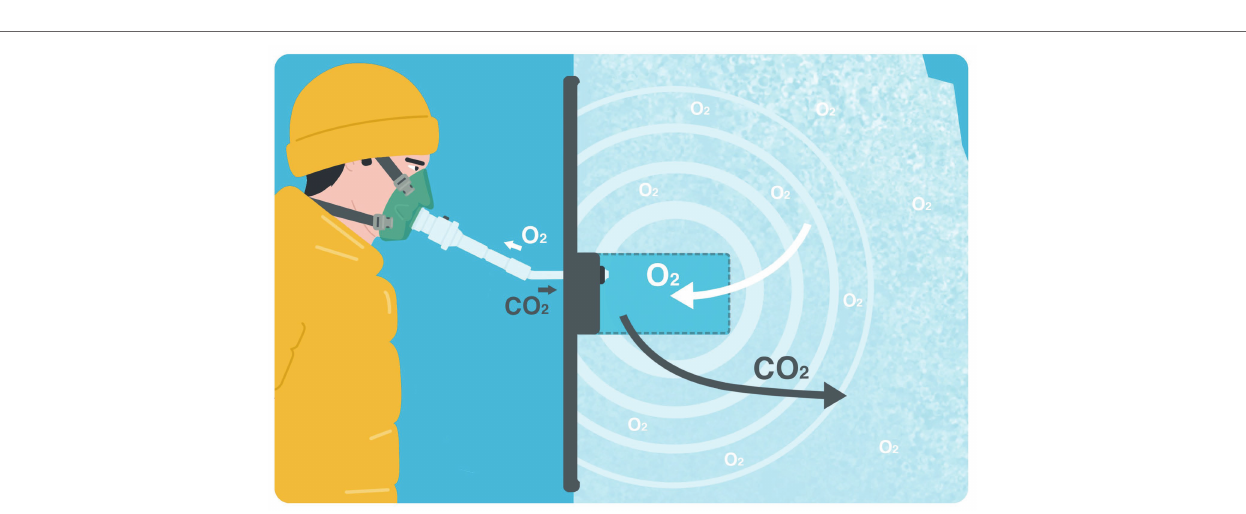
Frontiers in Physiology | www.frontiersin.org